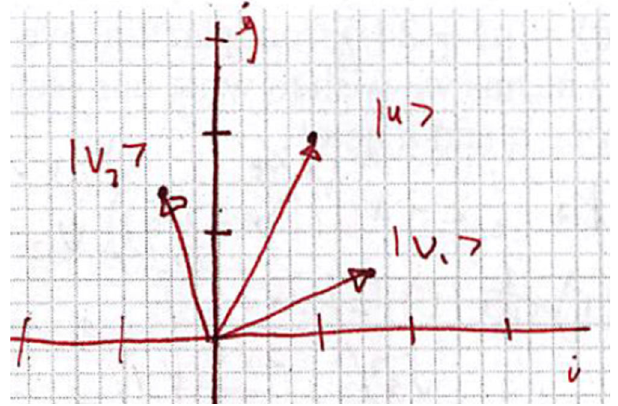
FIG. 2. Student work depicting all vectors on the same graph. The vectors j i i and j j i are represented by the horizontal and vertical axes, respectively. The new basis vectors, j v 1 i and j v 2 i , effectively form a rotated set of axes. Students confirm that the vector j u i remains unchanged regardless of which set of axes it is plotted against (so long as the appropriate components are used for each basis).